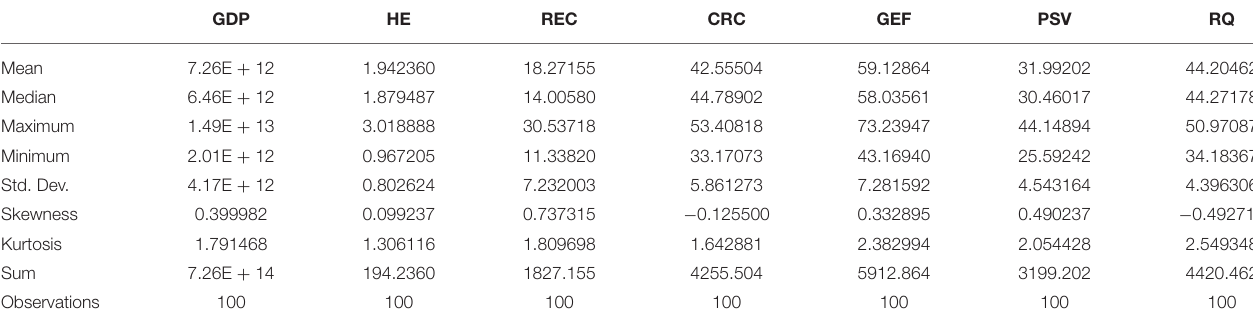
TABLE 3 | Descriptive statistics.